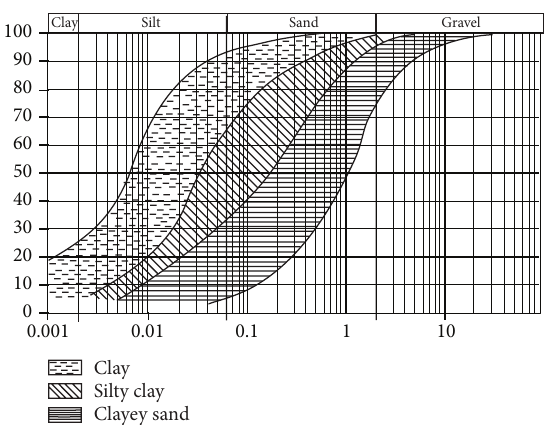
Figure 6: Particles size distributions of studied soil samples.